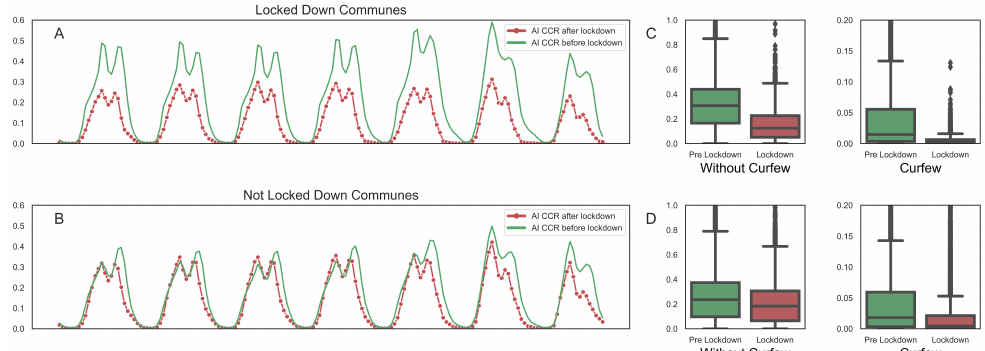
Figure 9. The effect of lockdown and curfew policies in Santiago, Chile. ( A ) Average weekly activity before and after lockdown for communes enforcing lockdown. ( B ) The same for communes not enforcing lockdown. ( C ) Additional impact of curfew on communes that enforced lockdown. ( D ) The same for communes that did not enforce lockdown.